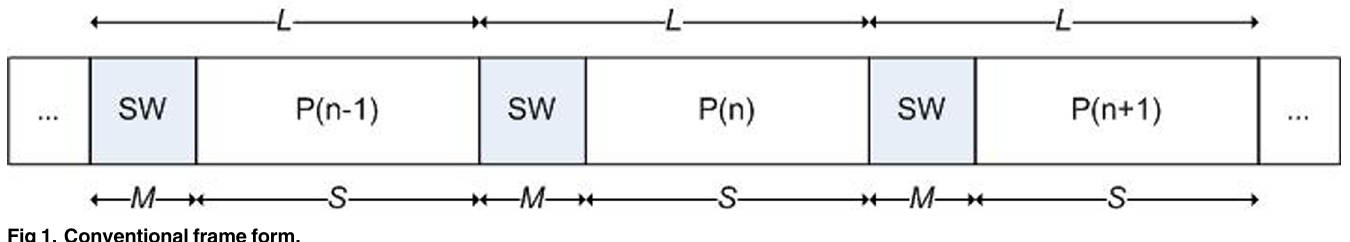
Fig 1. Conventional frame form.